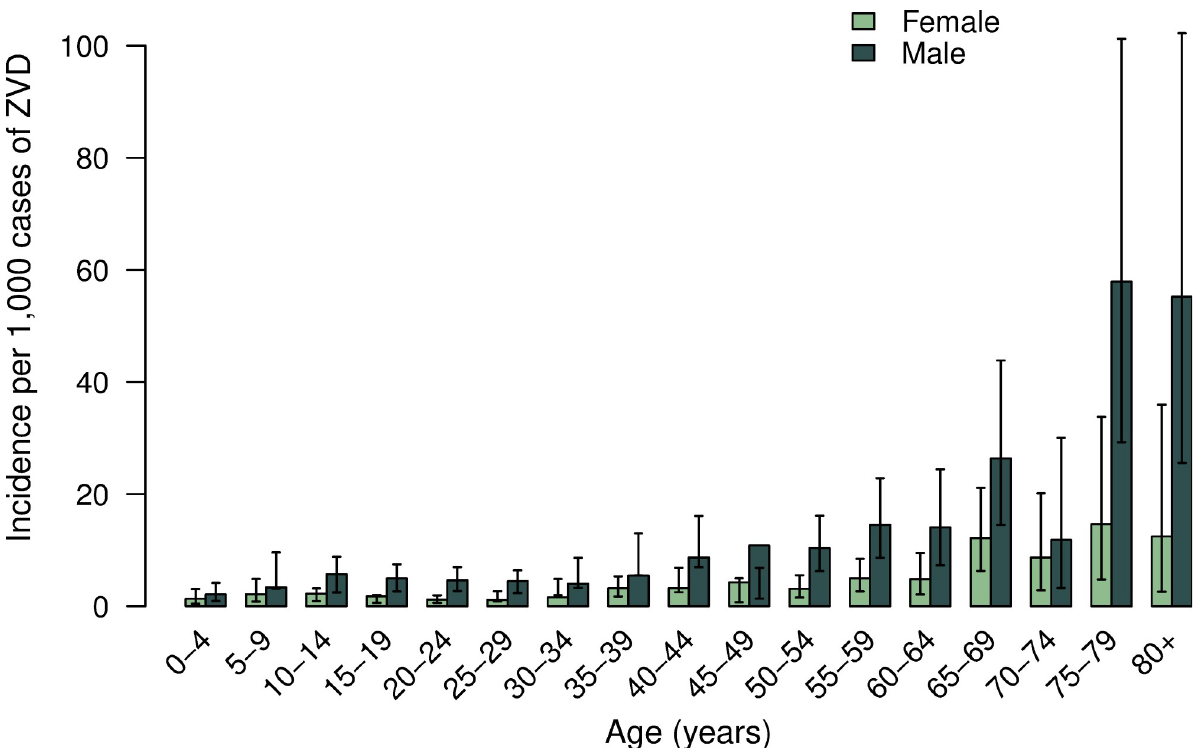
Fig 5. Cumulative incidence of ZIKV-associated neurological complications per 1,000 cases of ZVD by age group and sex in Colombia.